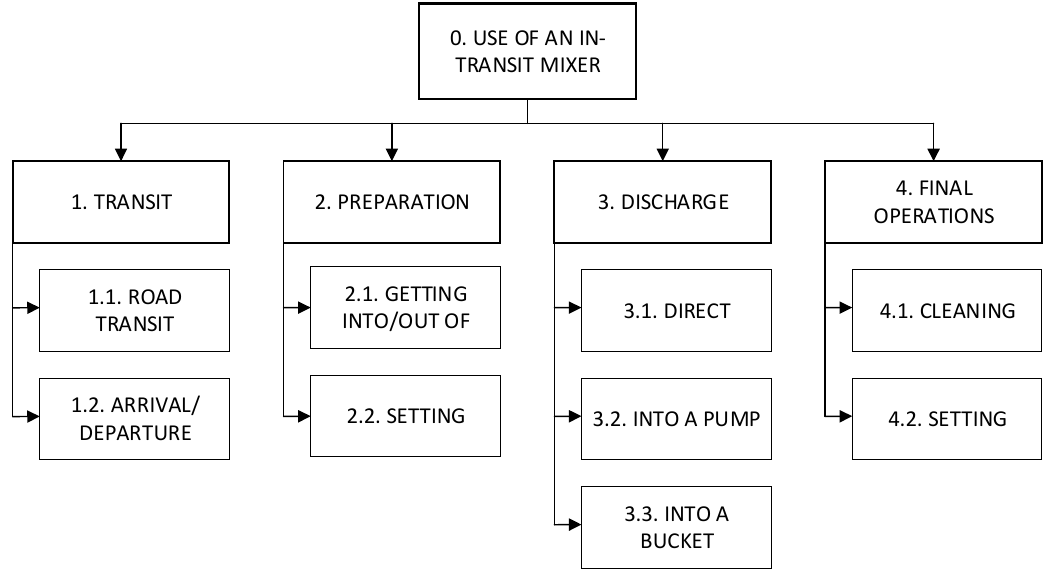
Figure 2. Application of the hierarchical task analysis (HTA) method.